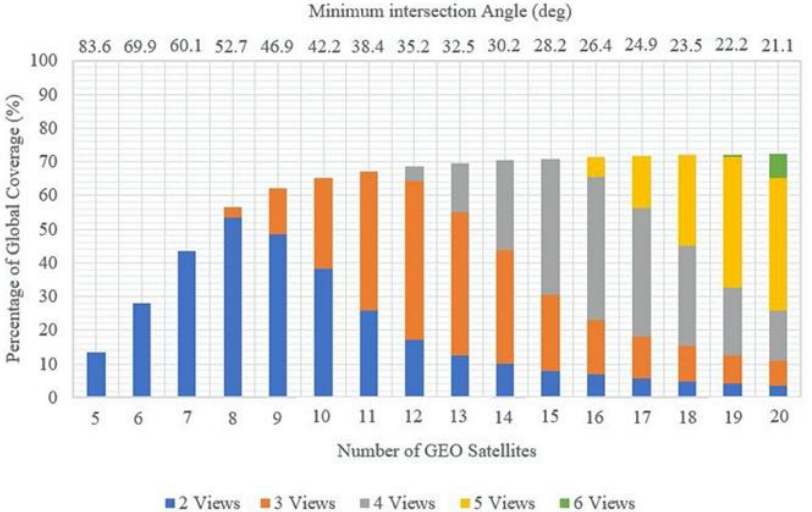
Figure 15. Percentage of global stereo coverage being viewed by two, three, four, five or six angles for increasing numbers of equally spaced GEO observers.